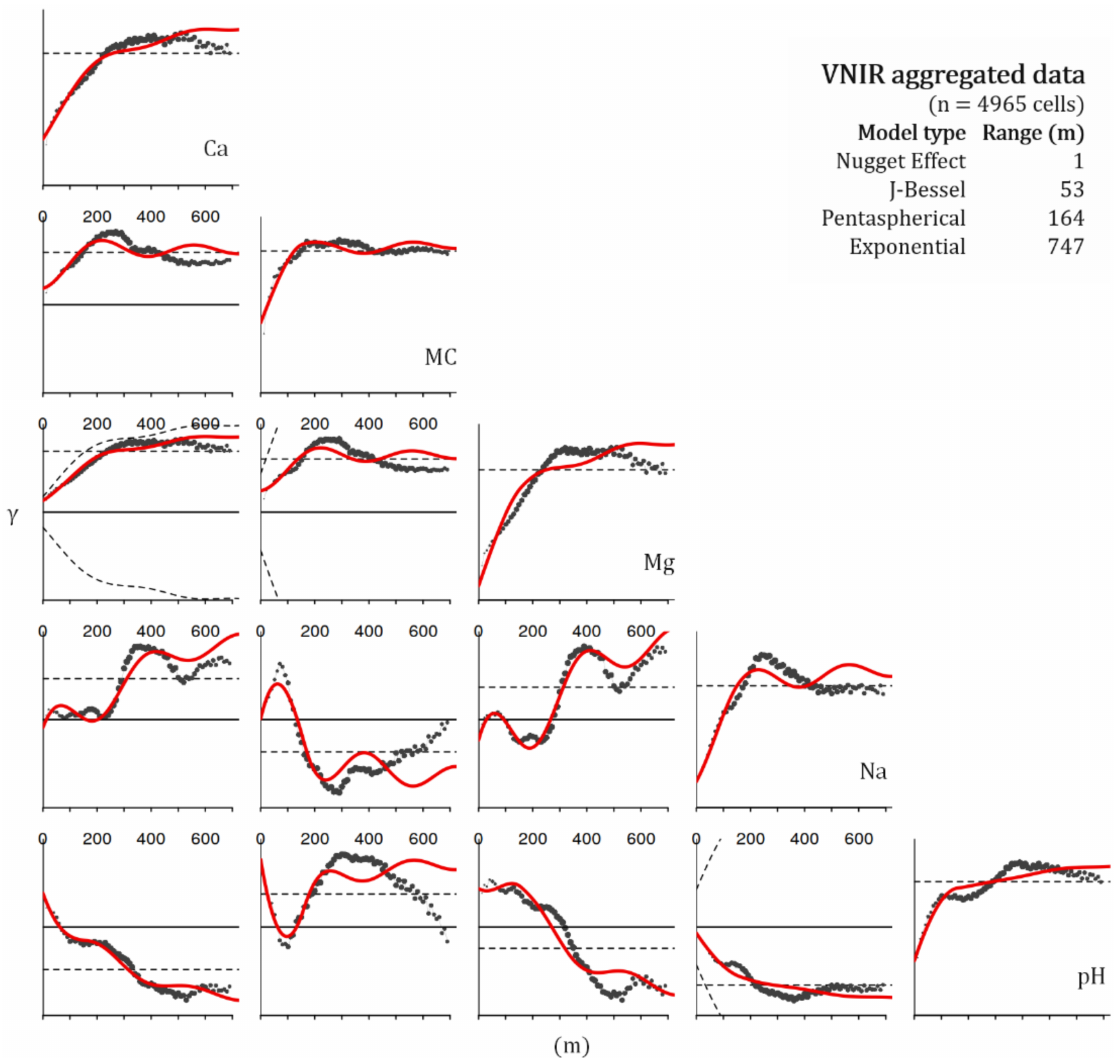
Figure 5. Matrix of VNIR aggregated data experimental variograms: large-scale direct isotropic variograms (diagonal) and cross-variograms (lag = 10 m, cutoff = 700 m). Red lines represent fitted models. Tabulated (upper left) are model type and range of detected spatial